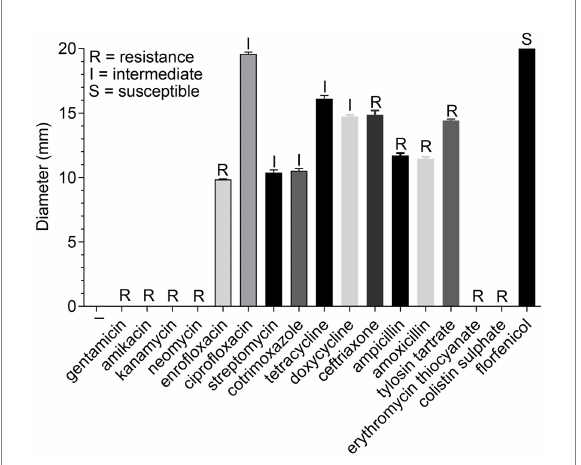
FIGURE 1 Determination of antibiotic resistance of Riemerella anatipestifer strain